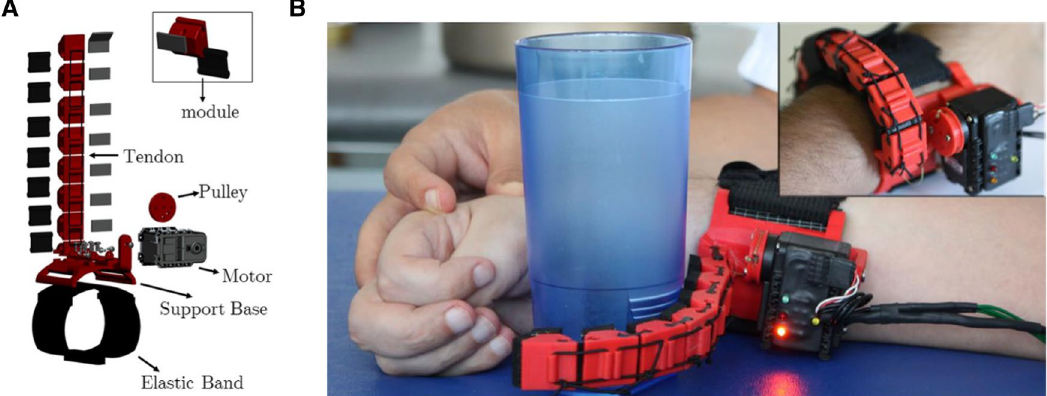
Figure 1. The Soft Sixth Finger. ( A ) The SSF has a modular structure. Each module is consist of a rigid ABS part and a soft Polyurethane part that acts like a soft joint. The finger is actuated by a tendon-driven system with a single motor. ( B ) Upper right corner: the finger can be worn at the forearm and can be wrapped around the wrist when not used. When in use, the SSF acts as a gripper with the rest of the hand (in this case a paretic hand is showed). [Original photographs taken by Gionata